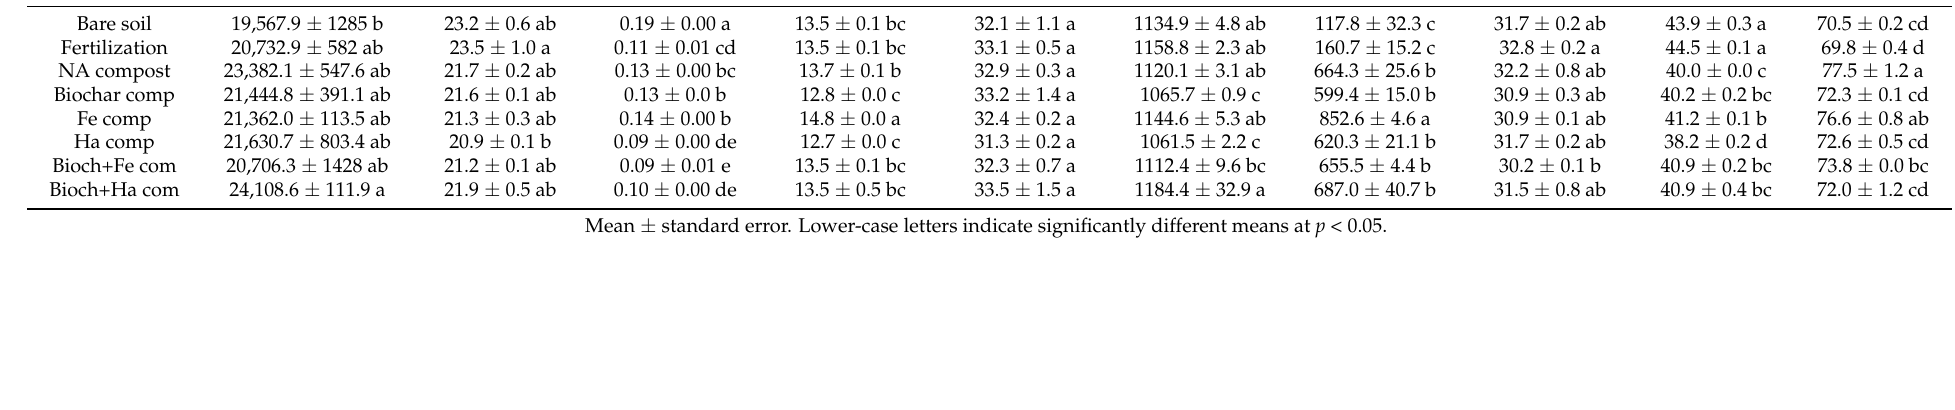
Table 3. Elemental composition of soil and compost amended soils after the greenhouse experiment according to ICP-OES spectroscopy.